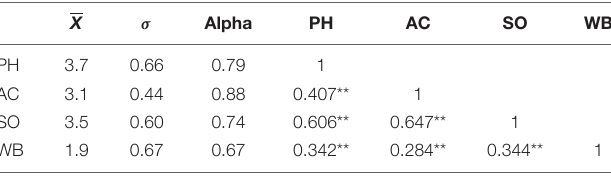
TABLE 1 | Univariate statistics and their relationship to school environment and